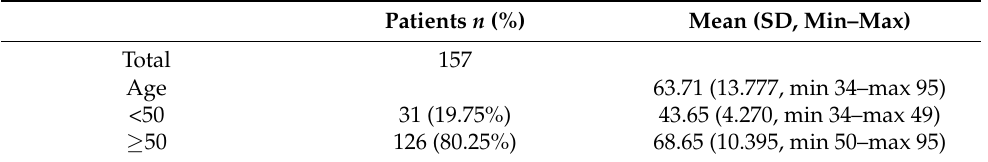
Table 1. Age characteristics of the 157 breast cancer patients included in the study.